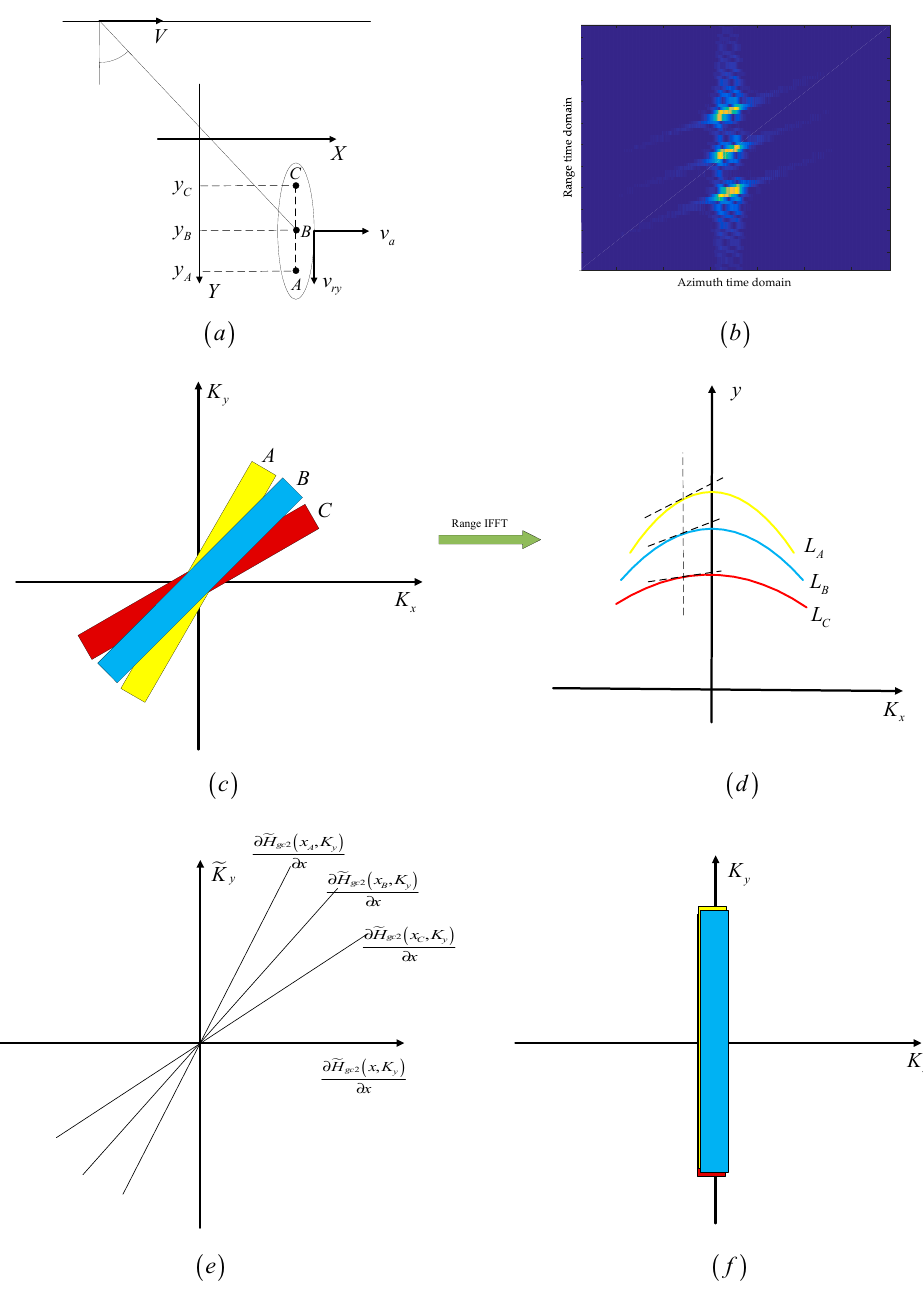
Figure 8. Schematic diagram of the second step of squint minimization: ( a ) Targets A, B, and C in the same azimuth bin after the first step of spectrum compression; ( b ) Imaging results obtained by the BP integral; ( c ) Envelopes of the targets in the azimuth wavenumber domain; ( d ) The second step of spectrum compression; ( e ) The factor of the second step of spectrum compression; ( f ) The 2-D wavenumber spectrum after the second step of spectrum compression.